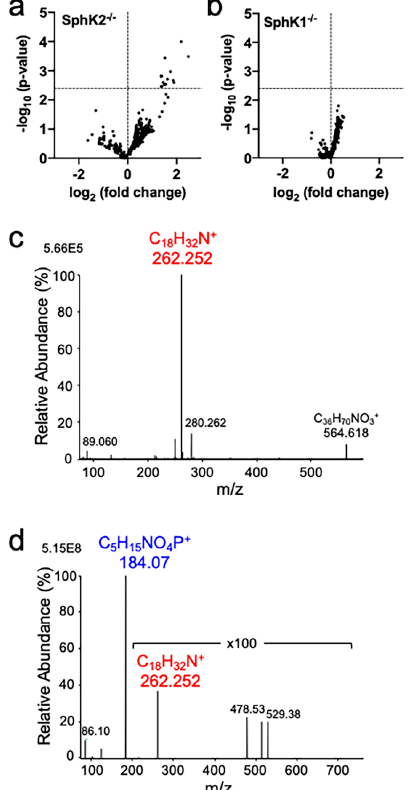
Figure 2. Sphingadiene-containing lipids are increased in hippocampus of SphK2 − / − mice. ( a , b ) Volcano plots showing p -value against fold change for each lipid identified in ( a ) SphK2 − / − and ( b ) SphK1 − / − mice, relative to wild-type (WT) control littermates (mean fold-change from six mice per group). The dotted line shows the threshold for statistical significance at Q < 0.1. Identities of sphingolipids significantly upregulated in SphK2 − / − mice are given in Table 1. ( c , d ) Q-Exactive HF-X CID-MS/MS product ion spectra for [M + H] + ions of ( c ) d18:2/18:0 ceramide and ( d ) d18:2/18:0 SM. Assignment as d18:2/18:0 ceramide was based on precursor ion m / z 564.534 and product ion m / z 262.252, which is diagnostic for sphingadiene. The m / z 184.073 choline phosphate product ion together with precursor ion m / z 729.590 is diagnostic of d36:2 SM, and the presence of the m / z 262.252 product ion allowed for the assignment of this lipid as d18:2/18:0 SM. Table 1. Lipid levels significantly di ff erent in the hippocampus of SphK2 − / − compared to wild-type mice. Lipid MW Cal. m / z Obs. m / z Ion WT Mean ± SD 1 Cer(d18:2 / 18:0)